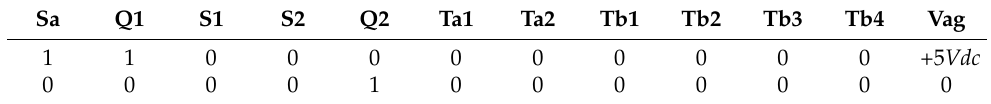
Table 2. Switching states for the proposed six-level inverter ( Ma <